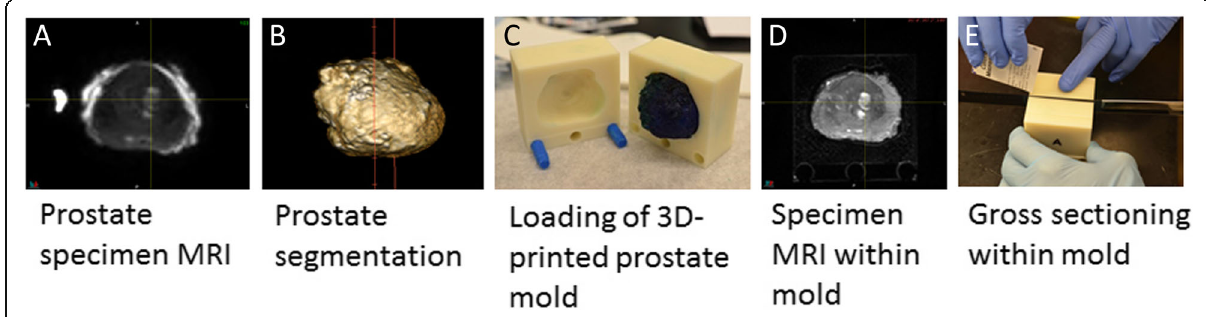
Fig. 1 Registration process step 1. Following prostatectomy, a 3D T2W MRI scan of the prostate specimen was performed ( a ), to accurately segment the specimen for generating a mold design ( b ). After 3D printing, the specimen was placed into the mold ( c ), and a second